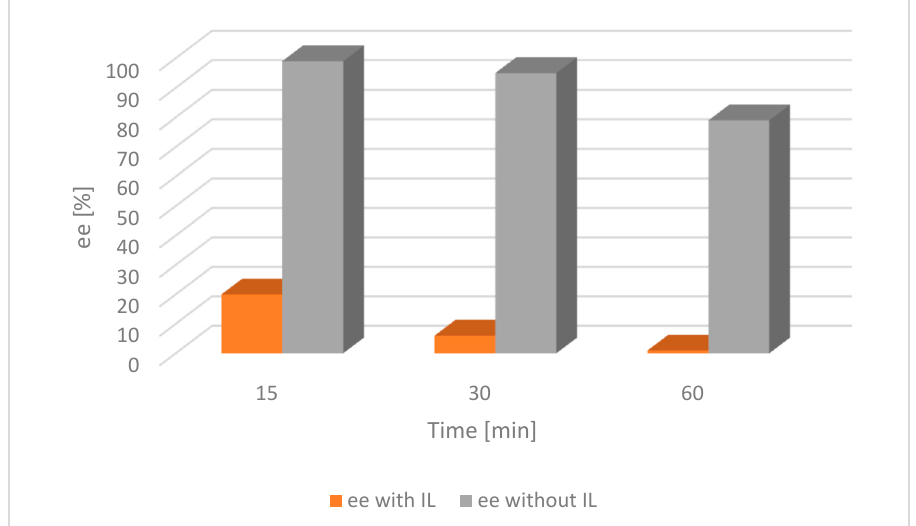
Figure 6. Comparison of the catalytic activity of [Ru(1)] with and without an IL for alcohol 2. [Ru(1)] 0.003 mmol, t BuOK 0.009 mmol, alcohol 0.25 mmol, [BMIM][NTf 2 ] 0.07 mmol, toluene 2 mL, a nitrogen atmosphere, RT; ee—enantiomeric excess of chiral alcohol in the mixture; the lower the ee, the nearer completion the desired racemization reaction.